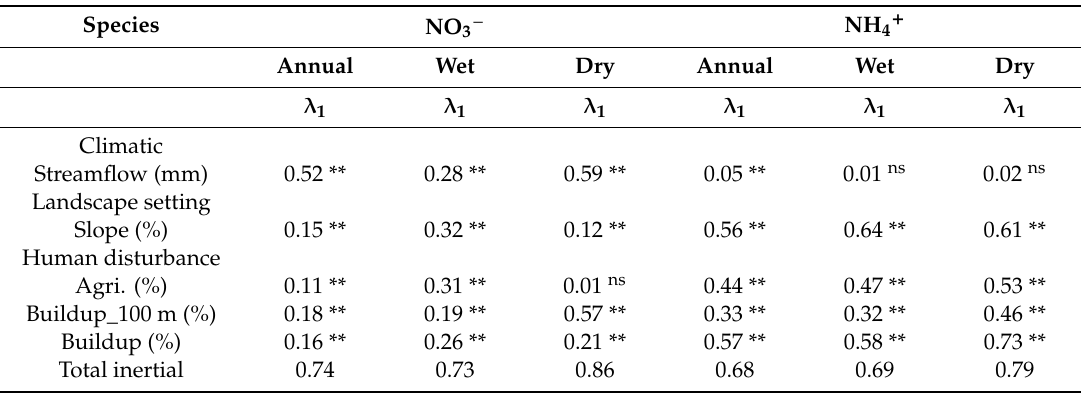
Table 4. The marginal e ff ects ( λ 1 ) and total inertia (total e ff ects) of climatic, landscape setting and human disturbance variables on NO 3 − and NH 4 + exports based on 43 sampling